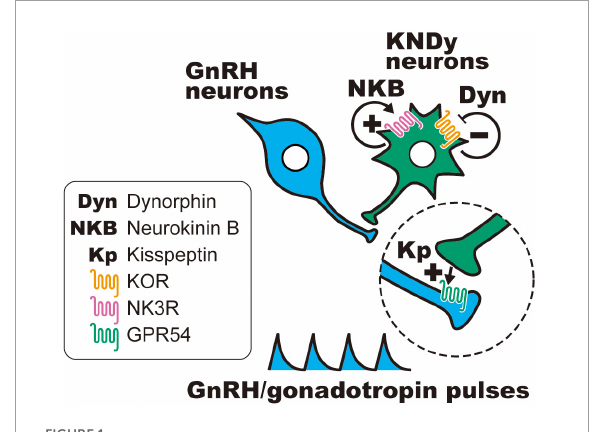
FIGURE1 Schematic illustration of the hypothetical mechanism of gonadotropin-releasing hormone (GnRH) pulse generation in female mammals. Dynorphin (Dyn) released from KNDy neurons arrests KNDy neuronal activity via inhibitory Gi/o-coupled κ -opioid receptors (KORs), and neurokinin B (NKB) initiates synchronized KNDy neuronal activity via stimulatory Gq-coupled NKB receptors (also known as NK3R) to release kisspeptin, and kisspeptin, in turn, stimulates GnRH release via stimulatory Gq-coupled kisspeptin receptors (also known as GPR54) expressed in GnRH